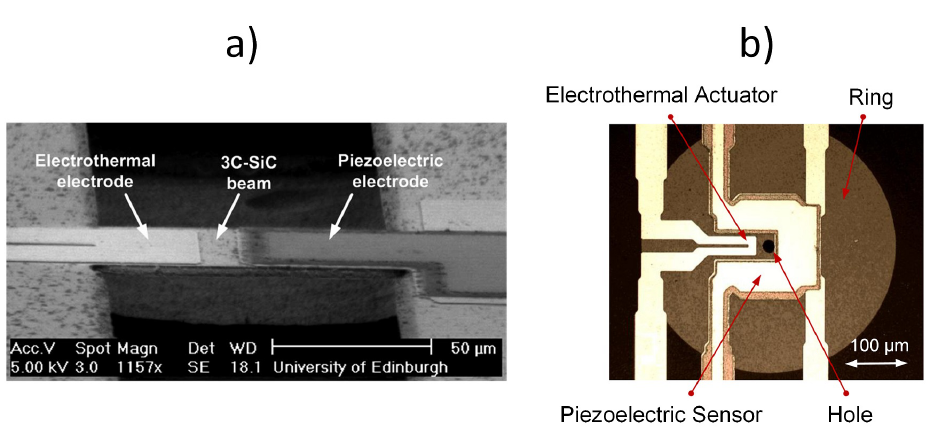
Figure 16. 3C-SiC ( a ) bridge [62] and ( b ) ring [63] resonators with a Pt electrode for electrothermal actuation and a piezoelectric port (Pt/PZT/Pt) for read out. c (cid:13) 2012 IEEE. Reprinted, with